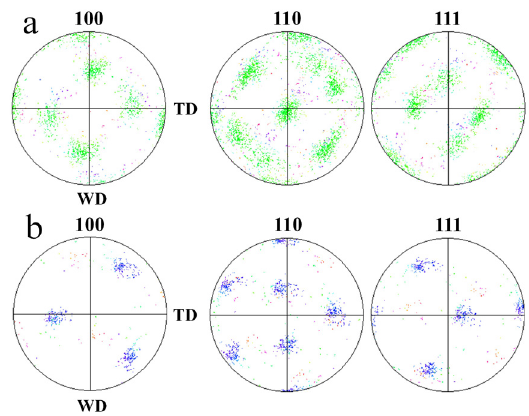
Figure 12. Pole figures for regions (a) and 4.1(b) 4.2.